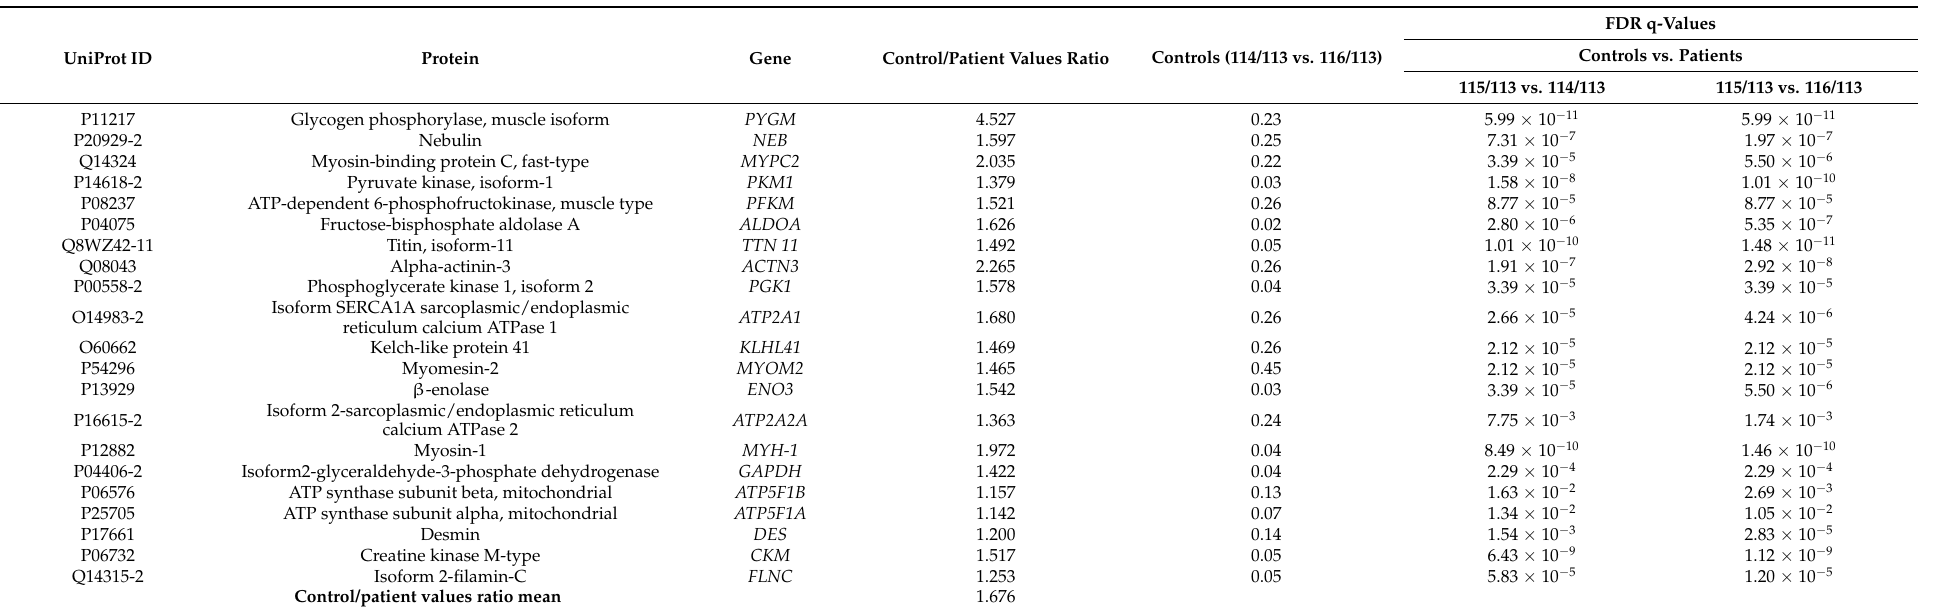
Table 3. Proteins with peptide number > 10, or with comparable peptide values’ distribution between control pool values, or with different peptide value distribution between control and GSDV patient pool values, respectively.